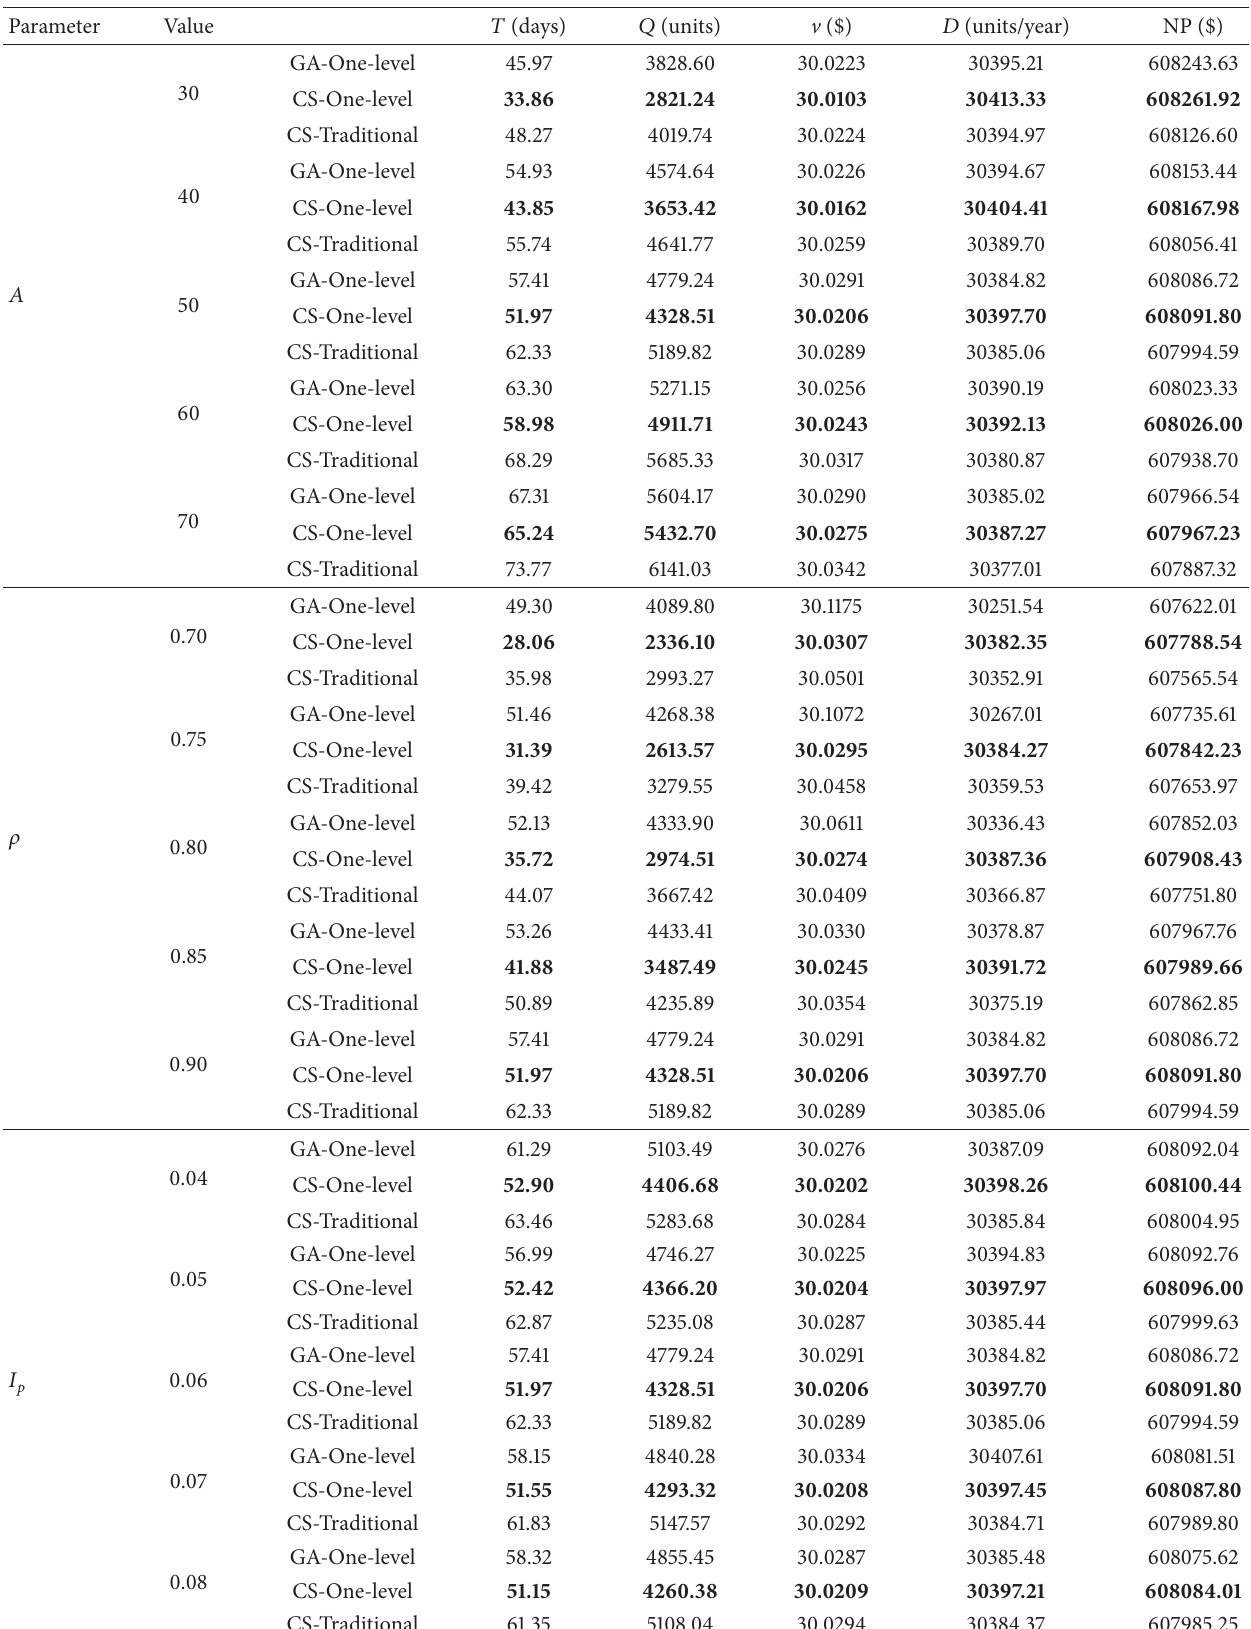
Table 2: The results of Example 2 for 𝑀 = 10